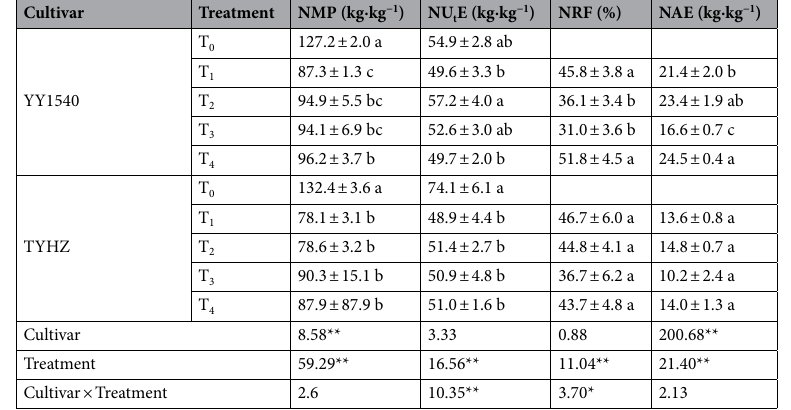
Table 5. Nitrogen utilization of in indica – japonica hybrid rice (‘Yongyou1540’, YY1540) and indica hybrid rice (‘Tianyouhuazhan’, TYHZ)under four nitrogen fertilization treatments in 2019. Values followed by different lower-case within the same column are significantly different among treatments. * p < 0.05; ** p < 0.01. NMP nitrogen dry matter production efficiency, NU t E nitrogen utilization efficiency, NRF nitrogen apparent recovery fraction, NAE nitrogen agronomic